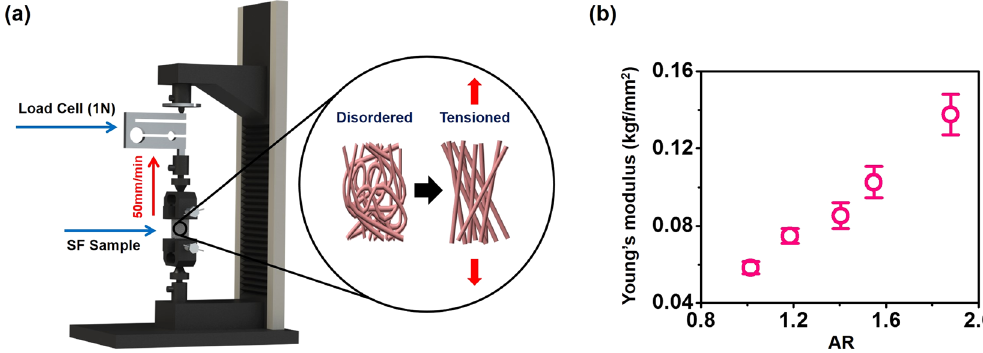
Figure 2. ( a ) An experimental setup to measure Young’s moduli of SF nanofibrous scaffolds. ( b ) Measured Young’s moduli as a function of ARs.